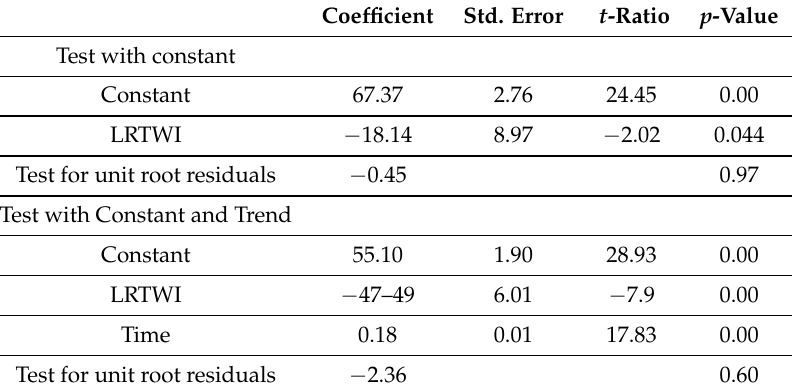
Table 3. Engle–Granger tests of